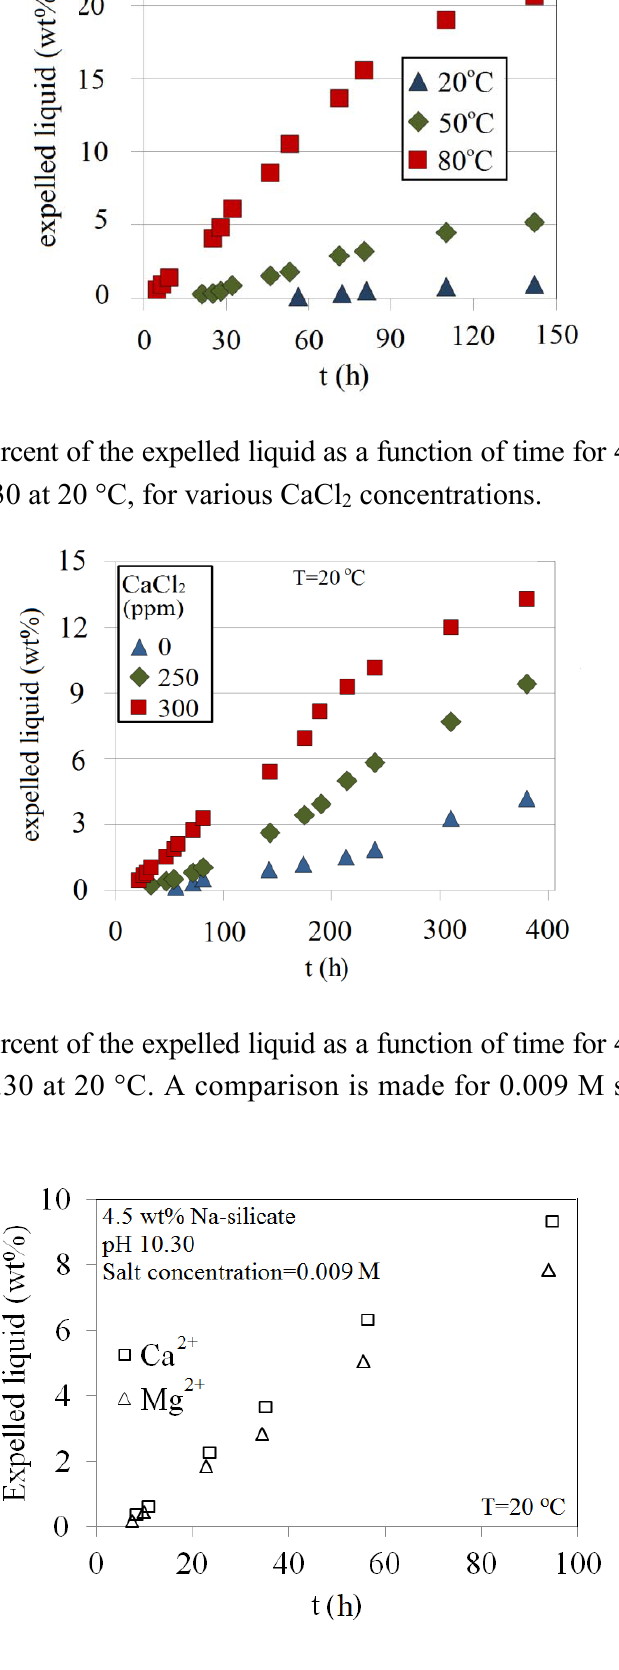
Figure 25. Weight percent of the expelled liquid as a function of time for a 4.5 wt% Na-silicate solution with a pH of 10.30 at temperatures of 20, 50 and 80 °C.